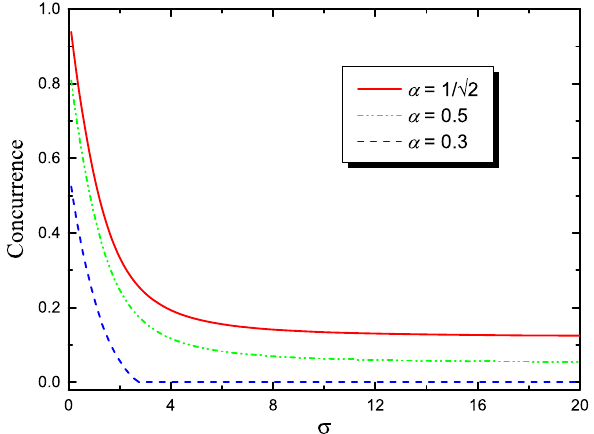
Fig. 8 The concurrence of the final state of two entangled qubits as a function of the rapidity σ of the expansion of the spacetime. The param- eters of the two qubits are the same. The qubit energy level difference is (cid:15) = 2, the inner product of the mode functions, defined in Eq. (21), is μ = 0 . 1, the mass of the scalar field particle is m = 0 . 01. The volume of the expansion is chosen to be ε = ε max = 19 , 999 . 5. The initial state of the qubits is α | 01 (cid:7) + β | 10 (cid:7)